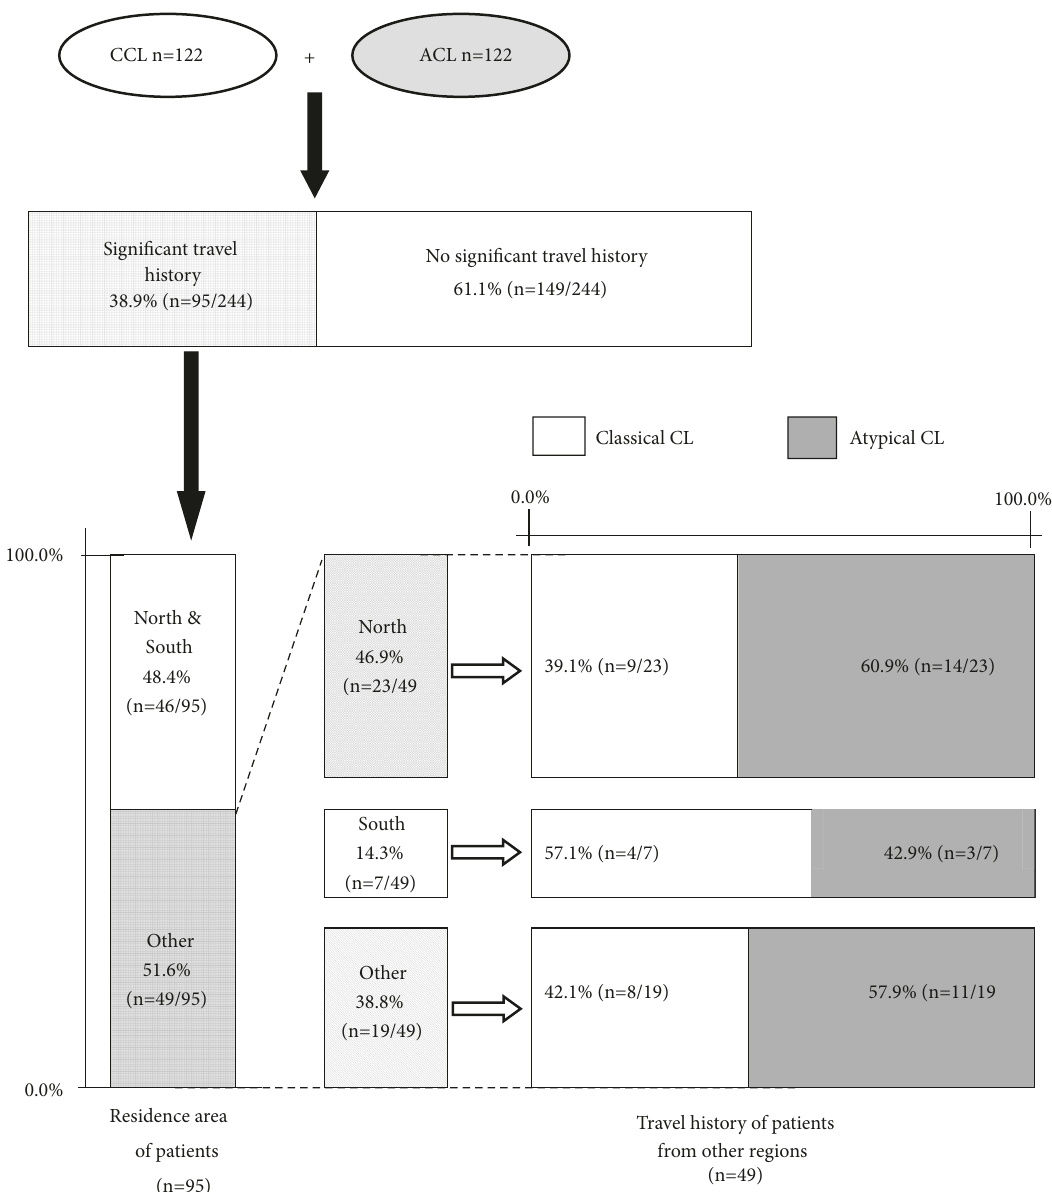
Figure 3: Association of CCL and ACL with travel history in subgroup (n=95) with a significant travel history in the study population.